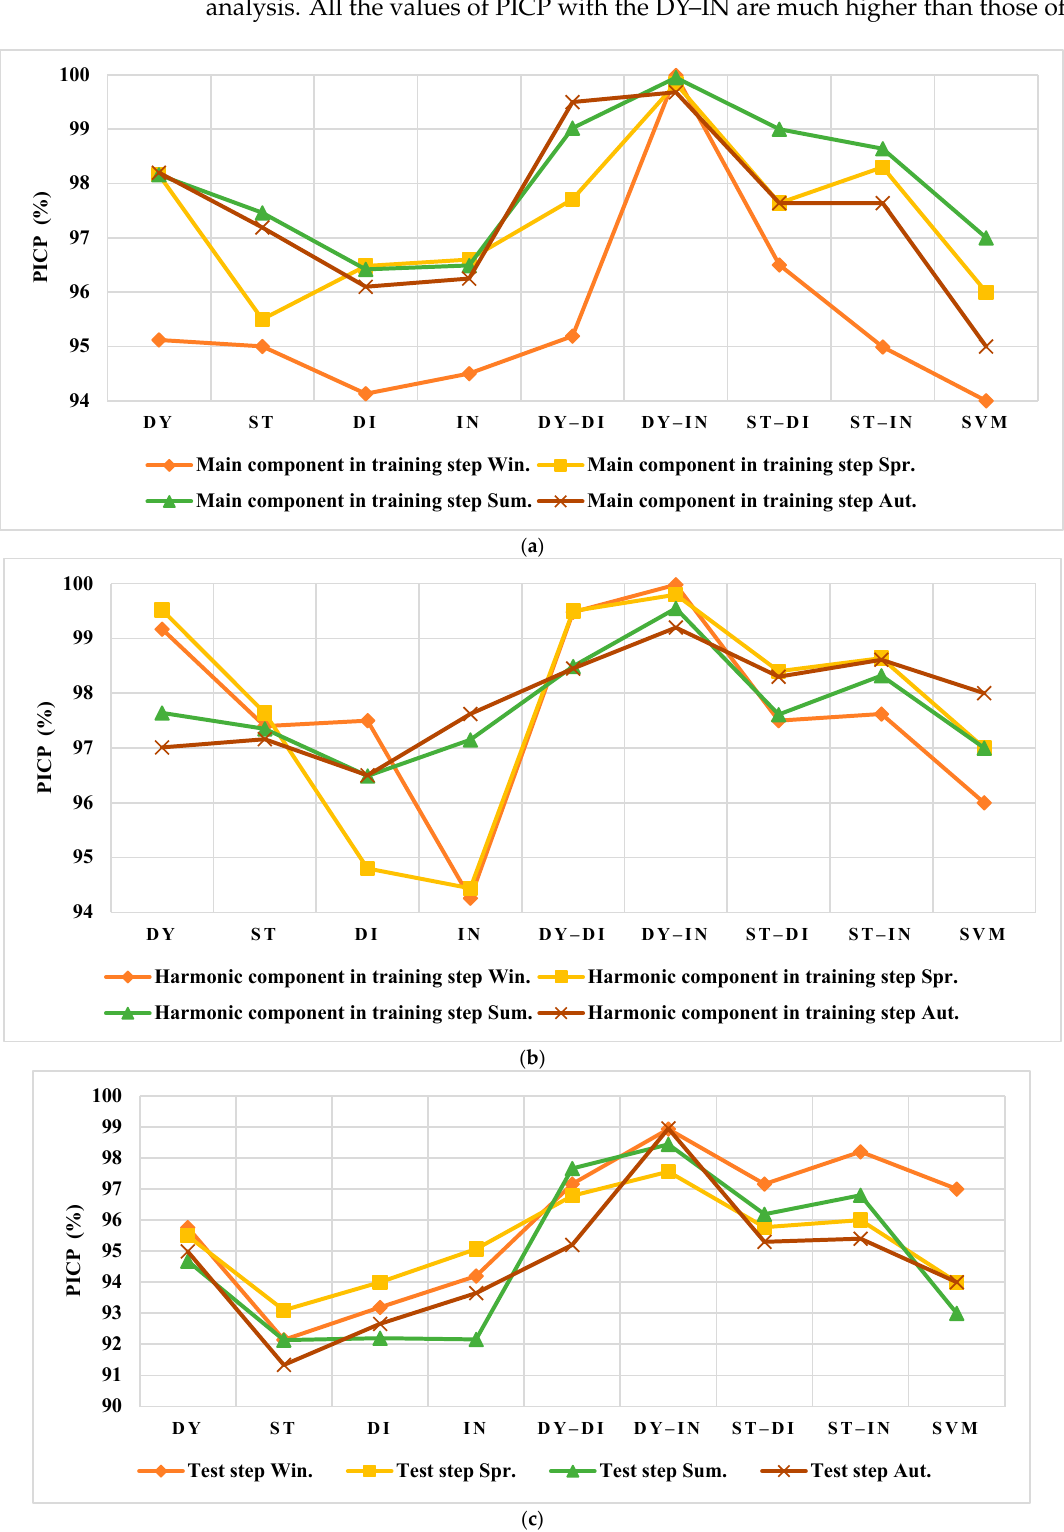
Figure 13. The results of PICP (%) for Spain: ( a ) Main Component in training step, ( b ) Harmonic Component in training step, ( c ) Test step